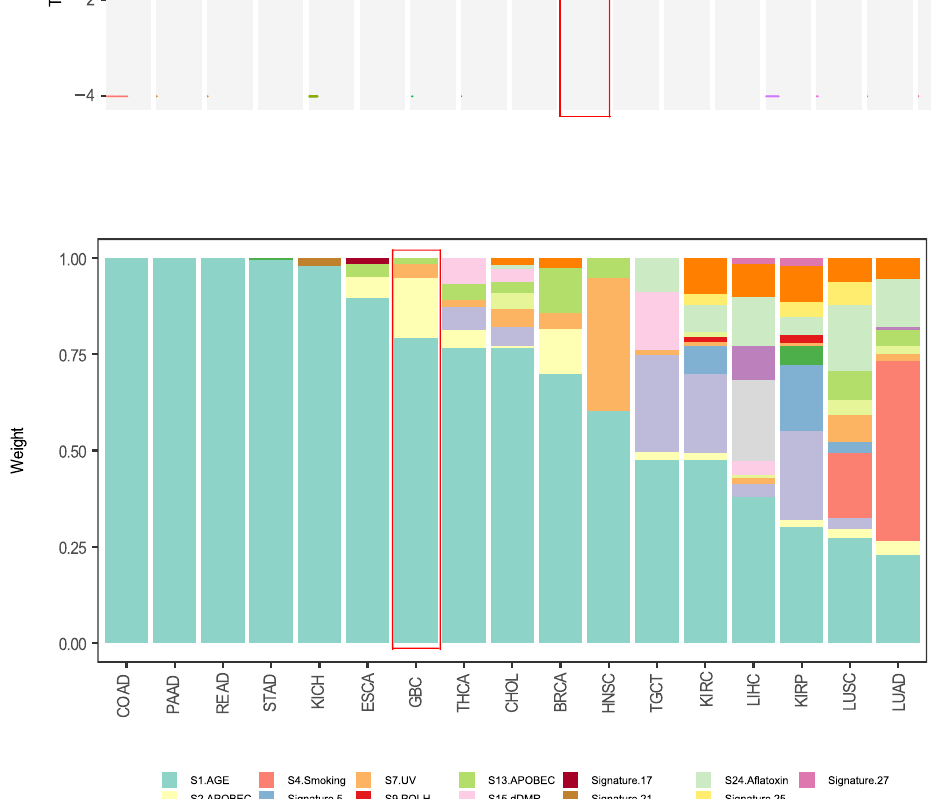
Fig. 1 Study overview and mutation characteristics of BilIN-related GBC. a Overall study design. b The TMB distribution of BilIN-related gallbladder carcinoma (GBC) in the context of stage-I samples from 16 TCGA cancer types. c Relative contributions of different mutational signatures (annotated by etiology factors) in GBC and 16 TCGA cancer types. b , c GBC is highlighted in the red box. READ: rectum adenocarcinoma; THCA: thyroid carcinoma; TGCT: testicular germ cell tumors; KICH: kidney chromophobe; BRCA: breast invasive carcinoma; CHOL: cholangiocarcinoma; PAAD: pancreatic adenocarcinoma; KIRC: kidney renal cell carcinoma; KIRP: kidney renal papillary cell carcinoma; LIHC: liver hepatocellular carcinoma; HNSC: head and neck squamous cell carcinoma; ESCA: esophageal carcinoma; COAD: colon adenocarcinoma; STAD: stomach adenocarcinoma; LUAD: lung adenocarcinoma; LUSC: lung squamous cell carcinoma.